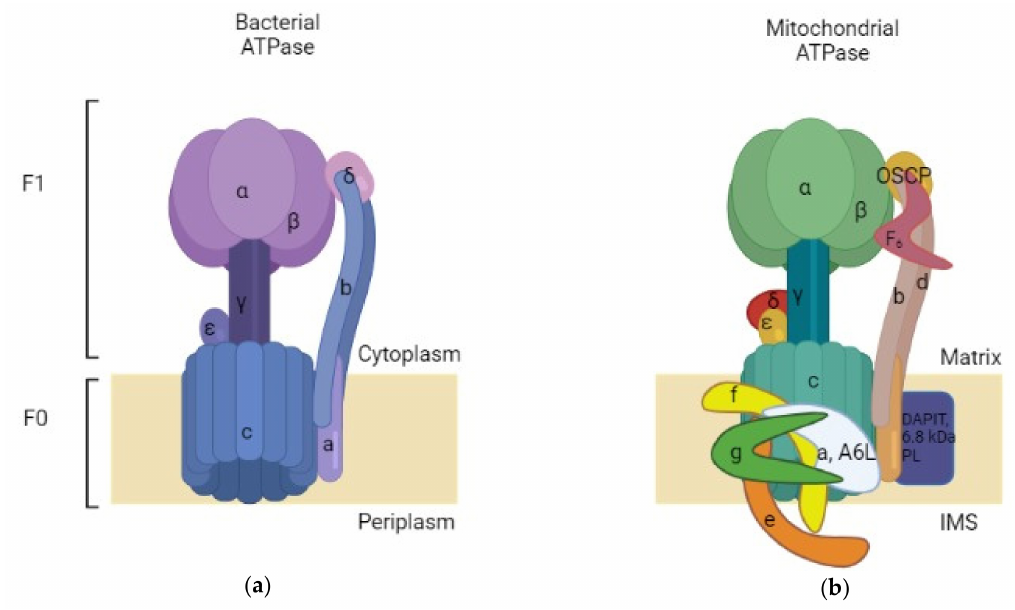
Figure 1. Simplified comparison between bacterial and mitochondrial ATPases. ( a ) Bacterial ATPase: comprised of two subunits: F0, inserted in the membrane, and F1, which is present in the bacterial cytoplasm; ( b ) Bovine mitochondrial ATPase: also comprised of a membrane-inserted F0 and an F1 subunit situated in the mitochondrial matrix. The mitochondrial ATPase is more complex than the bacterial enzyme. Made with